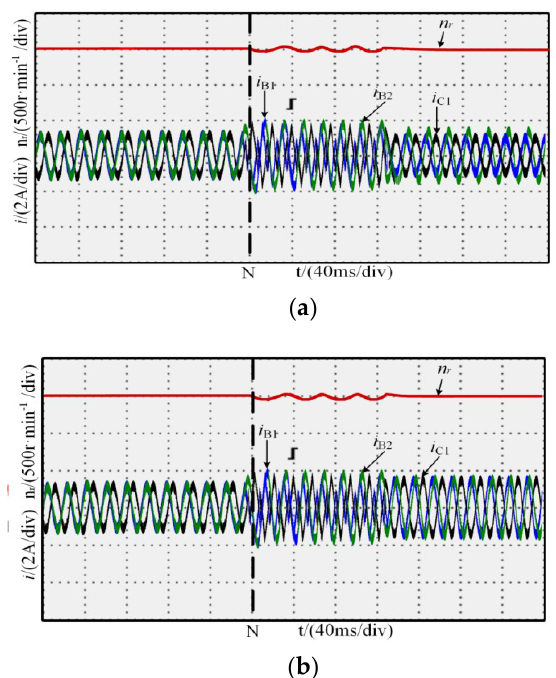
Figure 10. Fault-tolerant control experiment: ( a ) MCC; ( b ) MTO.